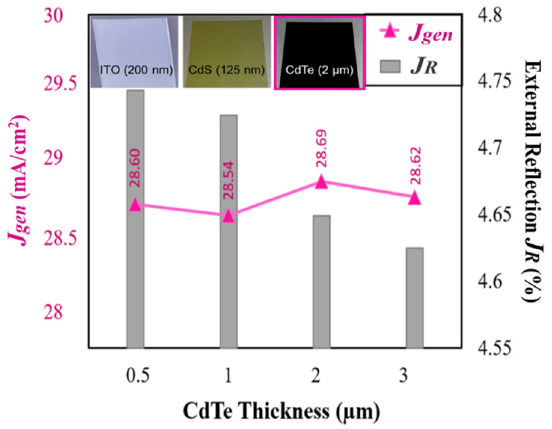
Figure 10. Generation current (line) and reflection as a function of CdTe thickness.